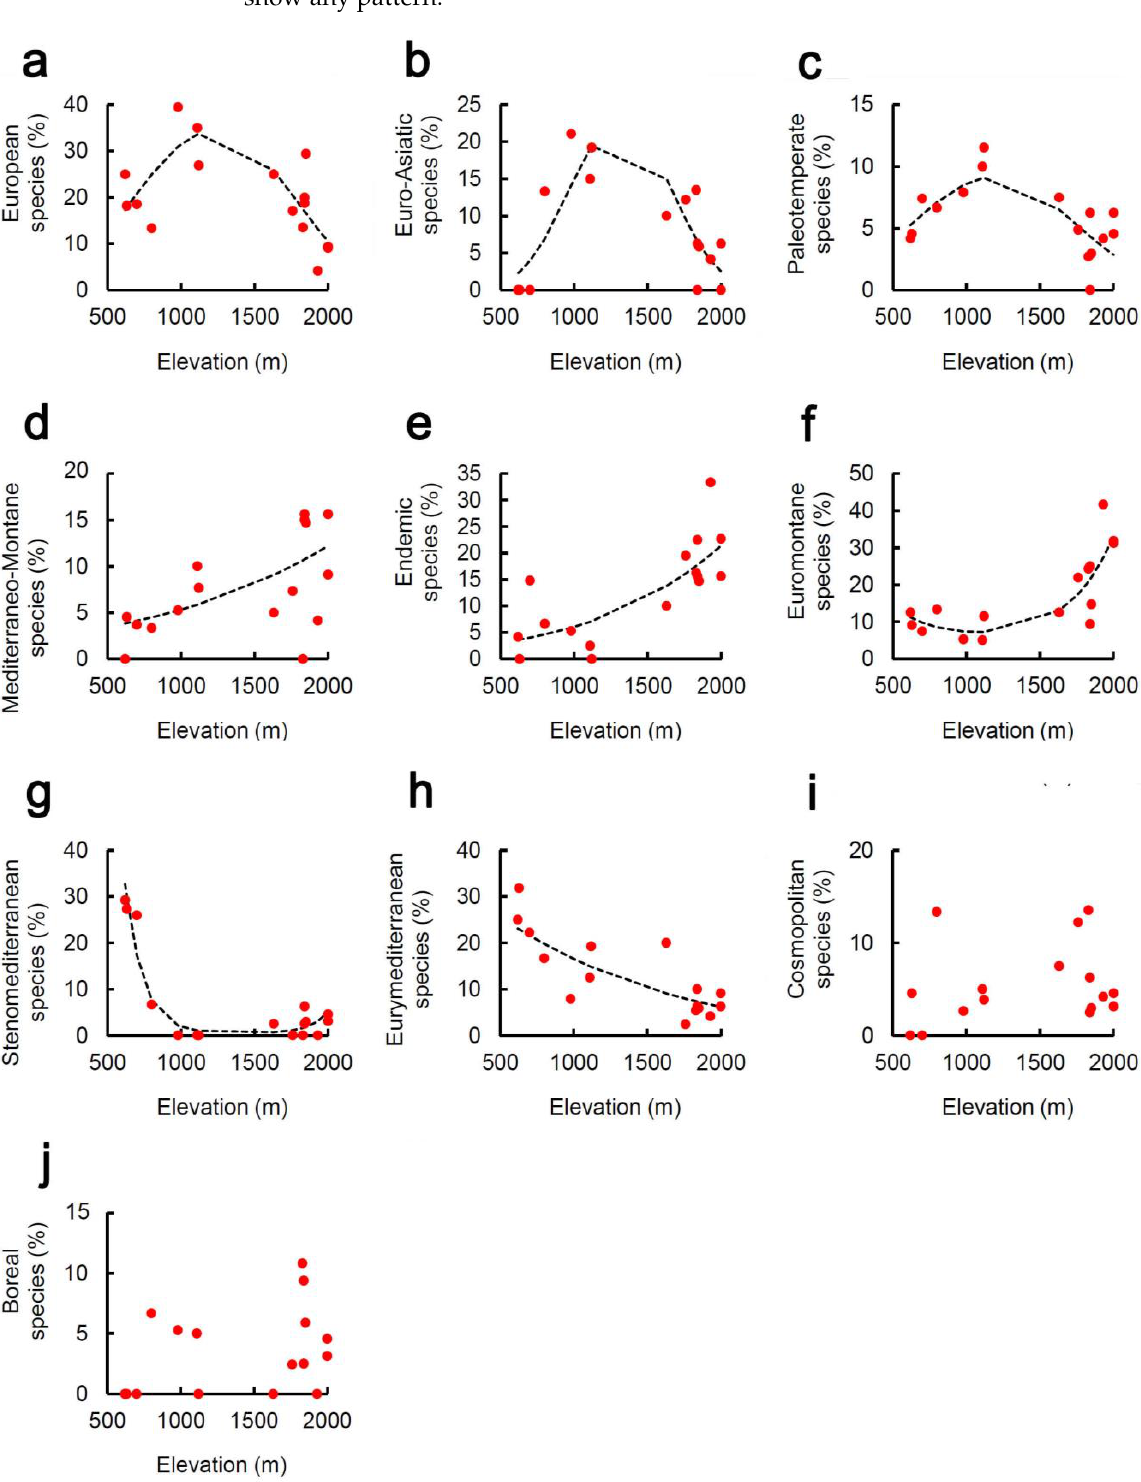
Figure 3. Relationship between percentage of chorotypes and elevation on a Central Apennine mountain (Mount Genzana): ( a ) European species, ( b ) Euro-Asiatic species, ( c ) Paleotemperate species, ( d ) Mediterraneo-Montane species, ( e ) Endemic species, ( f ) Euromontane species, ( g ) Stenomediterranean species, ( h ) Eurymediterranean species, ( i ) Cosmopolitan species, ( j ) Boreal species. Dashed lines are parabolic or monotonic fit obtained with generalized linear models. Fit parameters are reported in Table 1.